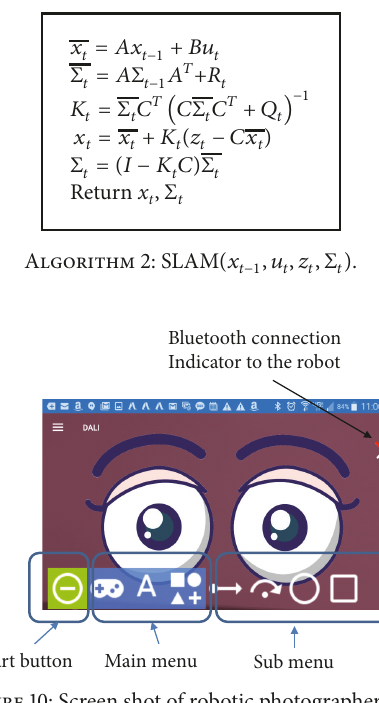
Figure 10: Screen shot of robotic photographer